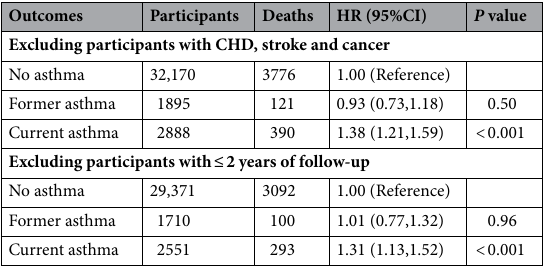
Table 2. Sensitivity analysis for association between asthma and all-cause mortality risk. CI confidence interval, CLRD chronic lower respiratory diseases, CHD coronary heart disease, HR hazard ratio, NA not available.